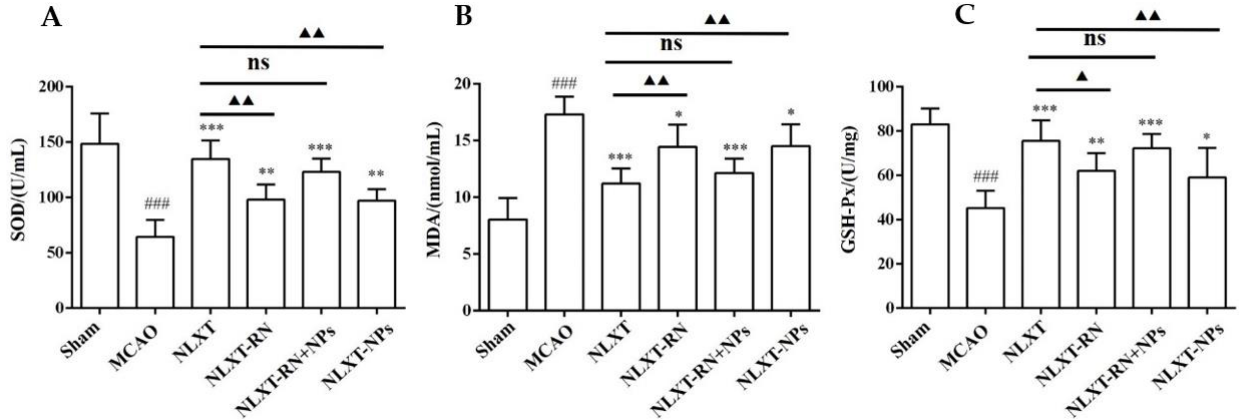
Figure 4. Effect of administration groups on the level of SOD ( A ), GSH-Px ( B ), and MDA ( C ) of